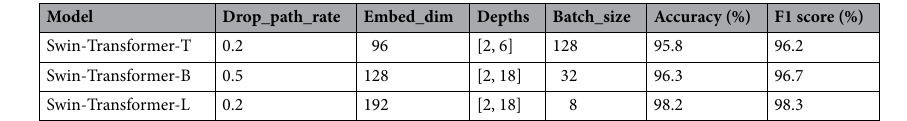
Table 1. Parameters and test accuracy of three variants of Swin Transformer.